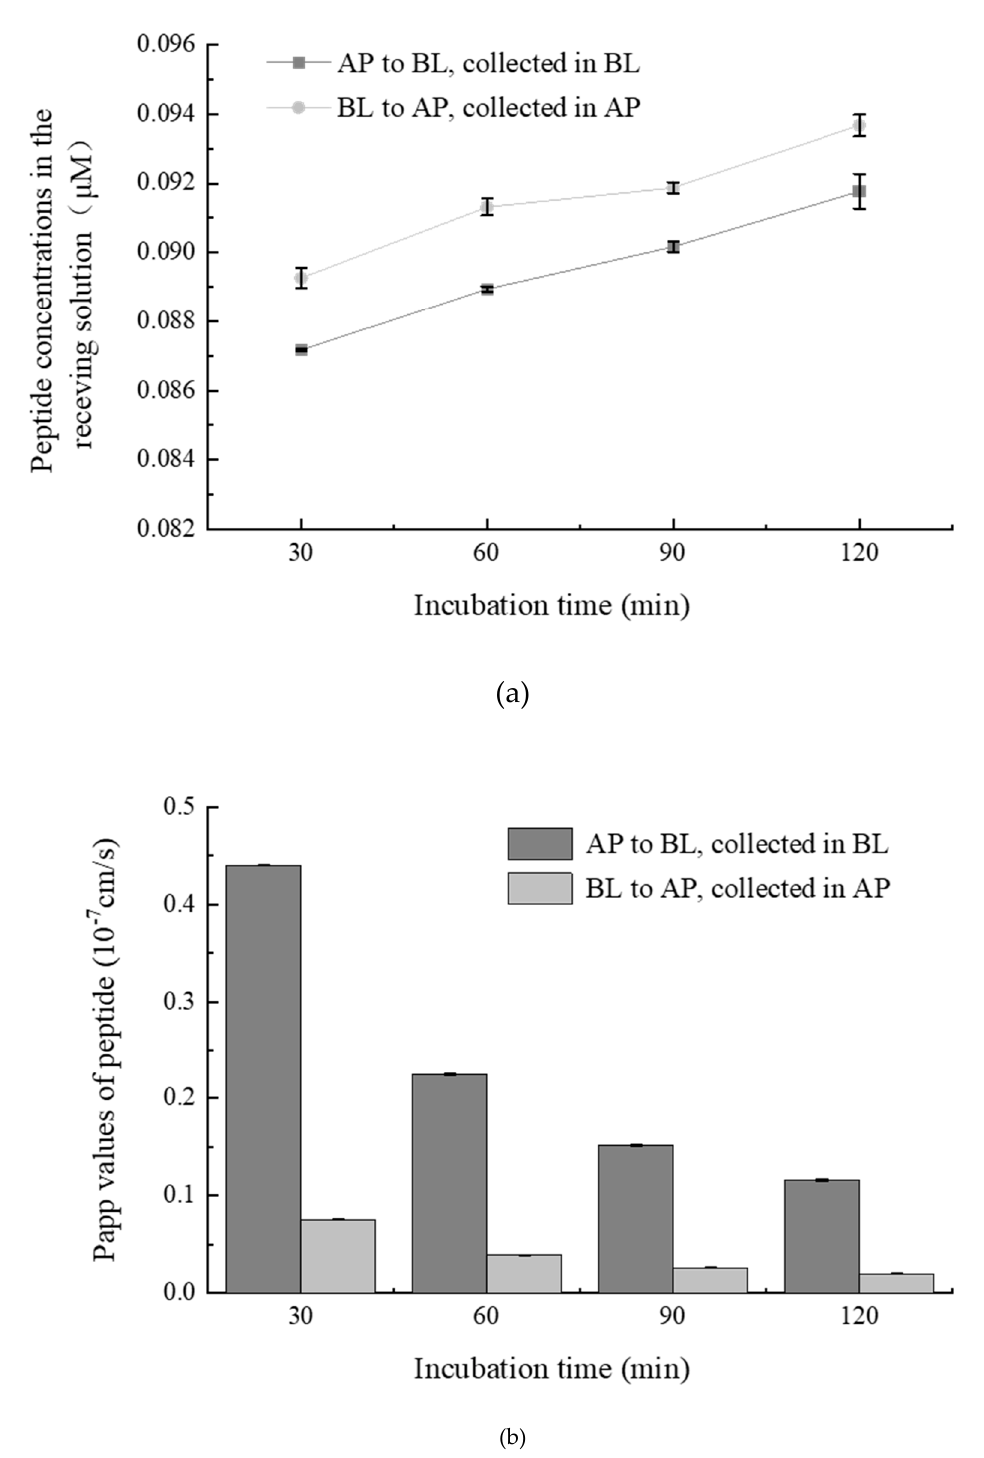
Figure 3. ( a ) Time-course of WGAPSL (2 mM, dissolved in hank’s balanced salt solution, HBSS, pH 7.4) transport across the Caco-2 cell monolayers from apical (AP) to basolateral (BL)and from BL to AP. ( b ) Papp (apparent permeability coefficient) values of peptides WGAPSL transport from AP to BL and collected in BL, and transport from BL to AP and collected in AP. Data are mean values ± standard variation of three replications and different letters indicated significant difference at p < 0.05.